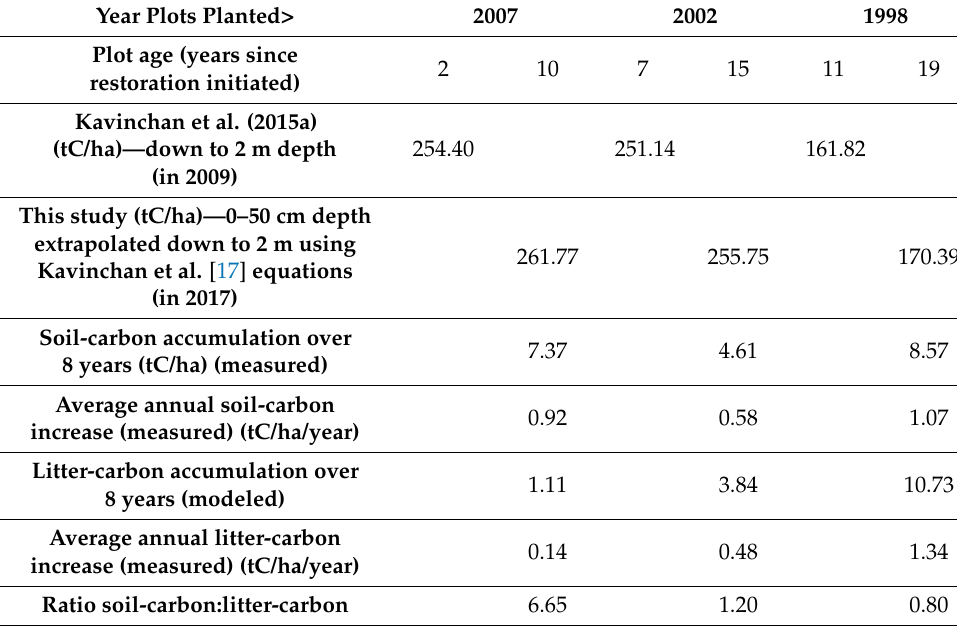
Table 3. Changes in measured soil carbon between two surveys 8 years